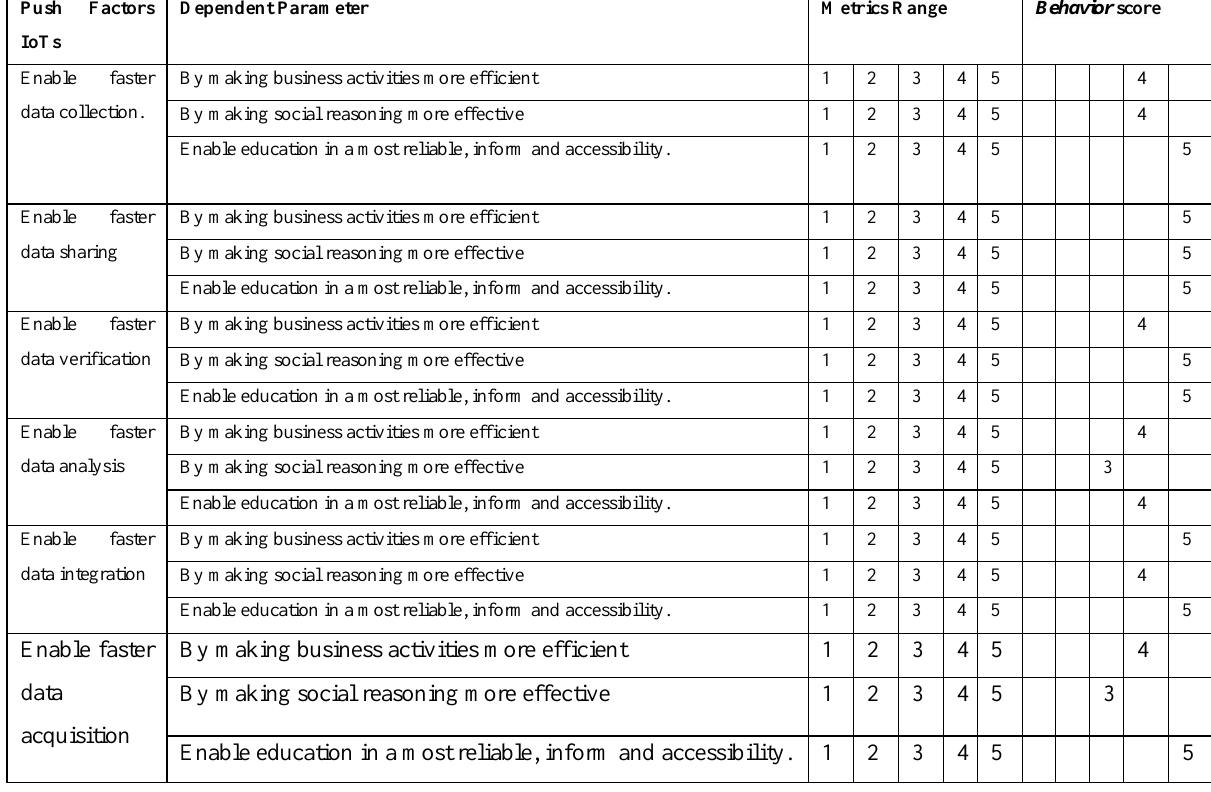
Table 2. Behavior oriented drive and influential function from IoTs on human psychology. Source: Owner